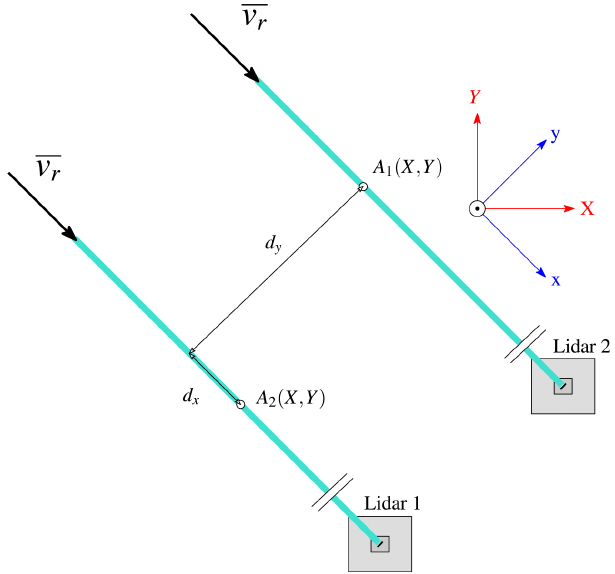
Figure 8. Schematic of the distances d x and d y defined by the two closest range gates for a given scanning